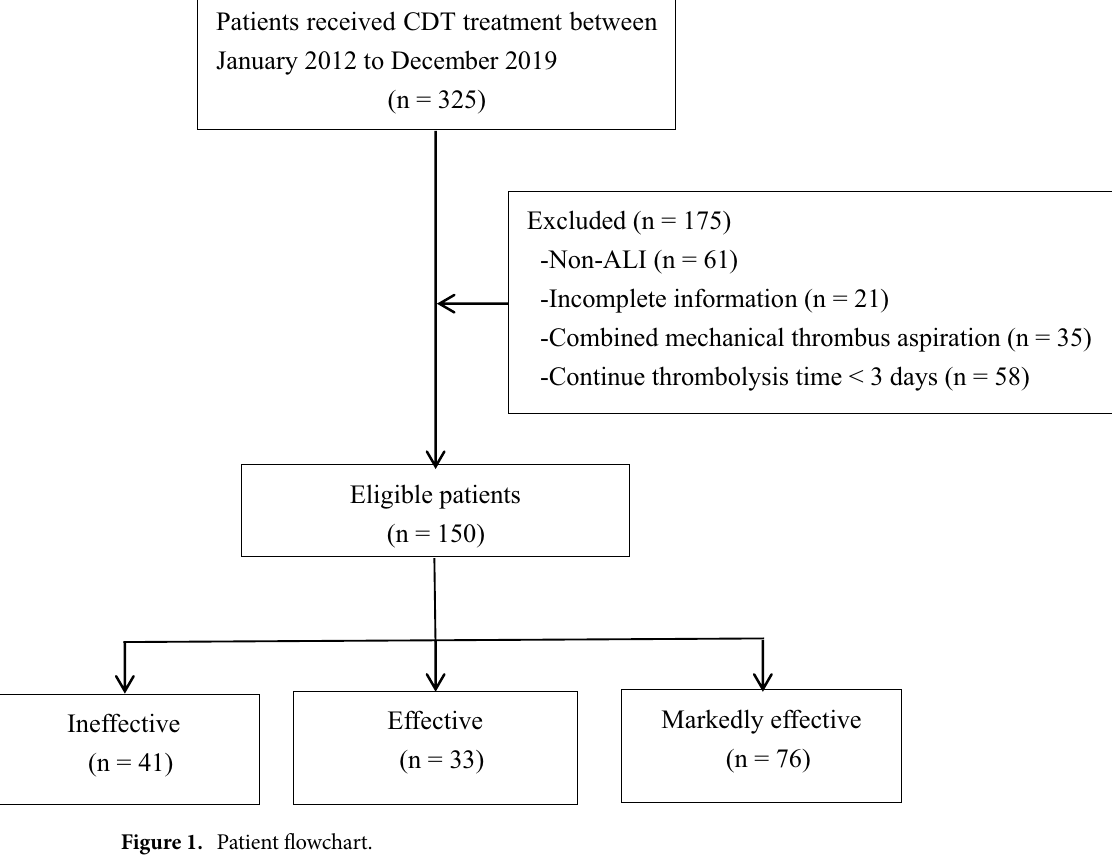
Figure 1. Patient